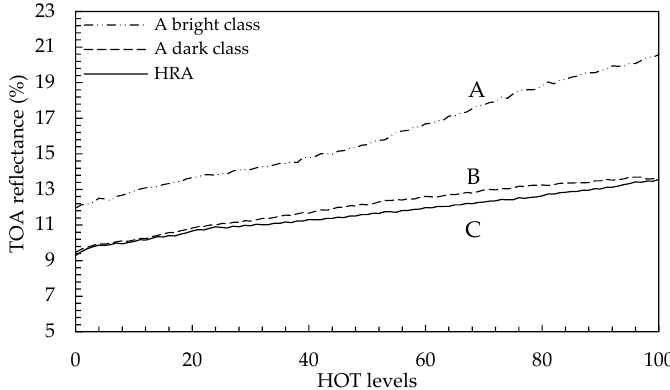
Figure 4. Dark-bound mean lines of 100 HOT levels (HOT values ranged from 0.0 to 5.0 with step size equal to 0.05) for two classes and all the land pixels in the first band of Landsat-8 OLI scene (Path 50/Row 25) acquired on 19 August 2014. Lines A and B were created with the dark-bound means of a bright class (mainly deforestation areas) and a dark class (dominated by shadow and shade pixels of mountains), respectively. Line C was formed with the dark-bound means calculated in the same way as in conventional HOT radiometric adjustment.